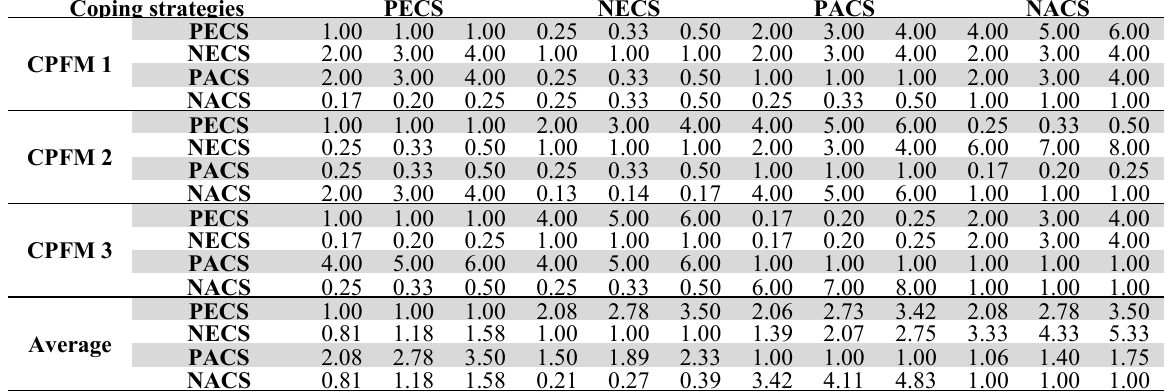
Fuzzy comparison matrix of coping strategies with negative emotions Coping strategies PECS NECS CPFM 1